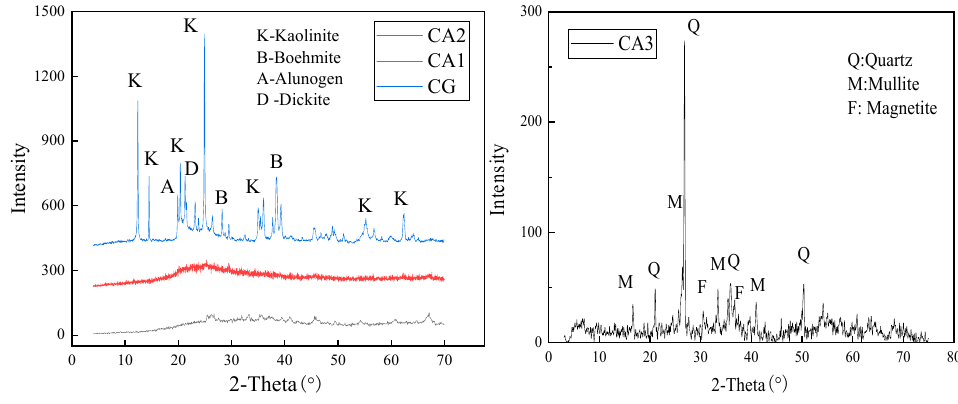
Figure 1. XRD patterns of three coal ash samples and coal gangue.